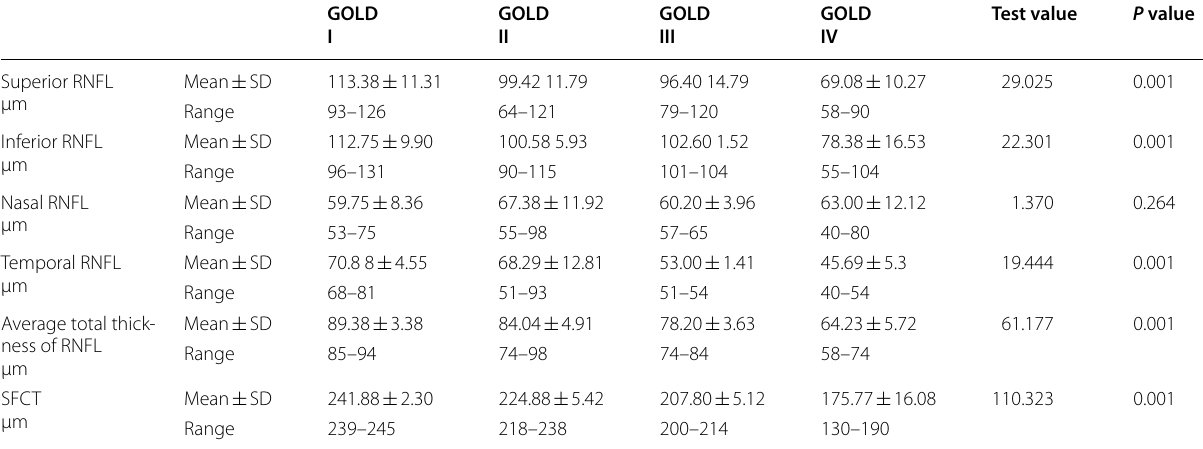
COPD chronic obstructive pulmonary diseases, GOLD Global Initiative for Chronic Obstructive Lung Disease, FEV 1 forced expiratory volume in the first second, RNFL retinal nerve fiber layer, SFCT subfoveal choroidal